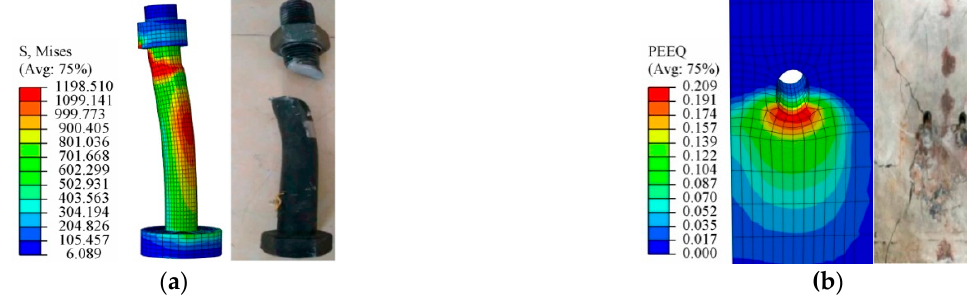
Figure 7. Comparison of typical failure modes between tests (Reprint with permission [19]; Copyright Year 2021, Publisher: Elsevier)[19] and FE results: ( a ) bolt shear failure; ( b ) concrete failure.